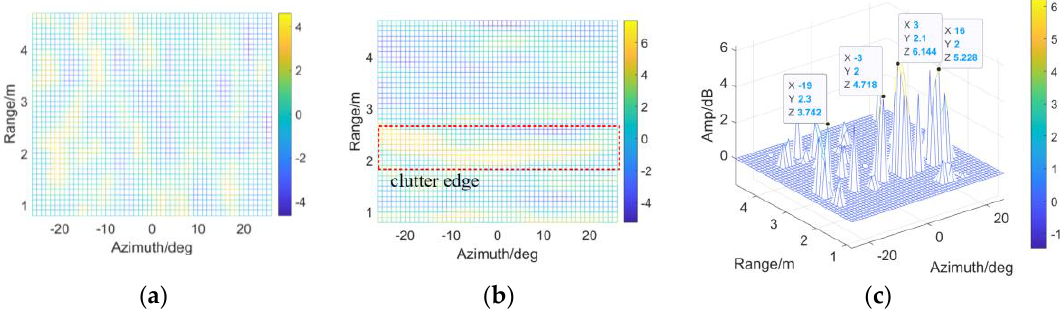
Figure 16. Detectability improvement and the VIs: ( a ) VI in azimuth; ( b ) VI in range; ( c ) 𝜂 of the scene.